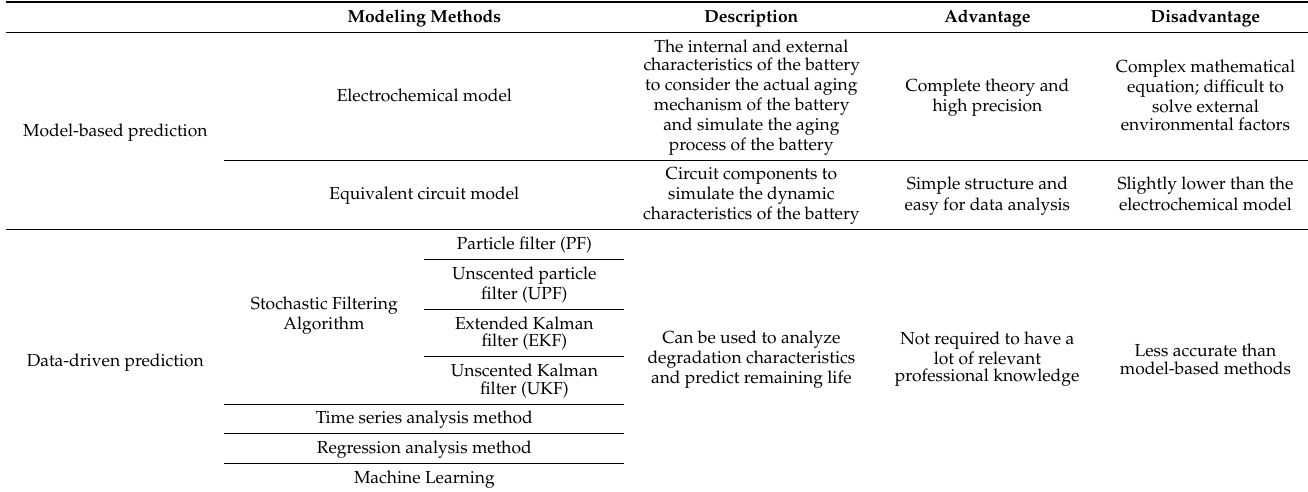
Table 7. Comparing various methods for SOH estimation and RUL